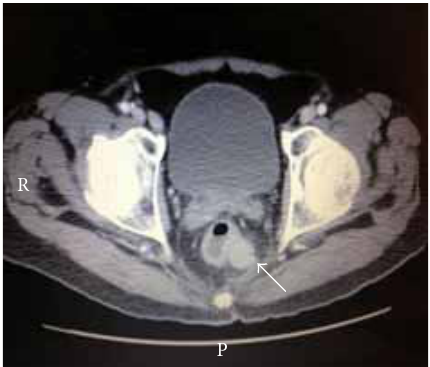
Figure 3: Staging CT scan showed a pulmonary nodule identified in the left lower lobe which is 1.8 × 1.8cm in diameter.